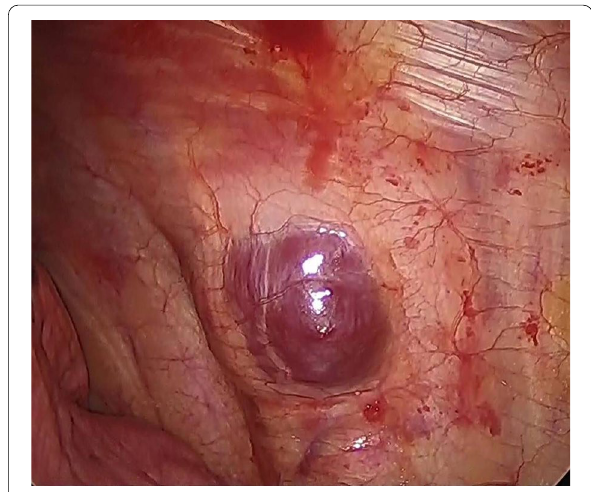
Fig. 3 Intraoperative findings. A dark red, soft tumor was found in the left chest wall